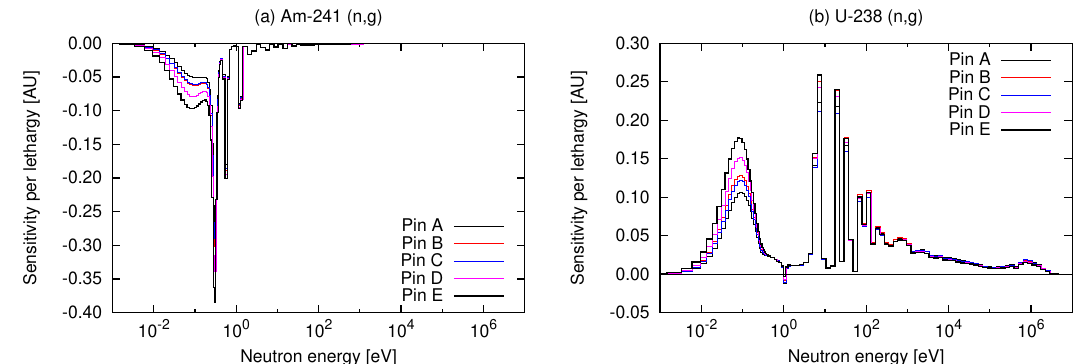
Figure 5: Sensitivity of Am-241 number density at 19.2 GWD/t to (n, γ ) cross section in the BWR assembly with void ratio of 0%